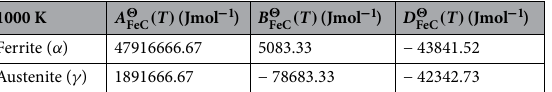
Table 1. Fitting coefficients describing free-energy densities of ferrite and austenite in Fe–C system with 0.018 mole-fraction carbon at 1000 K with A � FeC ( T ) , B � FeC ( T ) and D � FeC ( T ) corresponding to the second-, first- and α , γ zeroth-order terms 42 , and � . ∈ { }